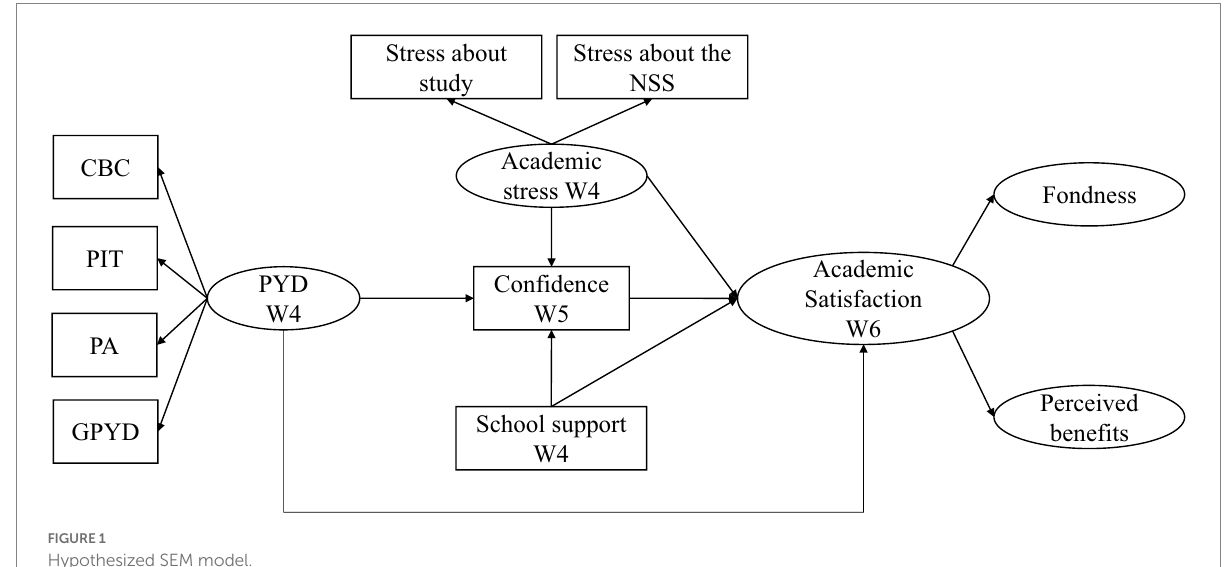
FIGURE 1 Hypothesized SEM